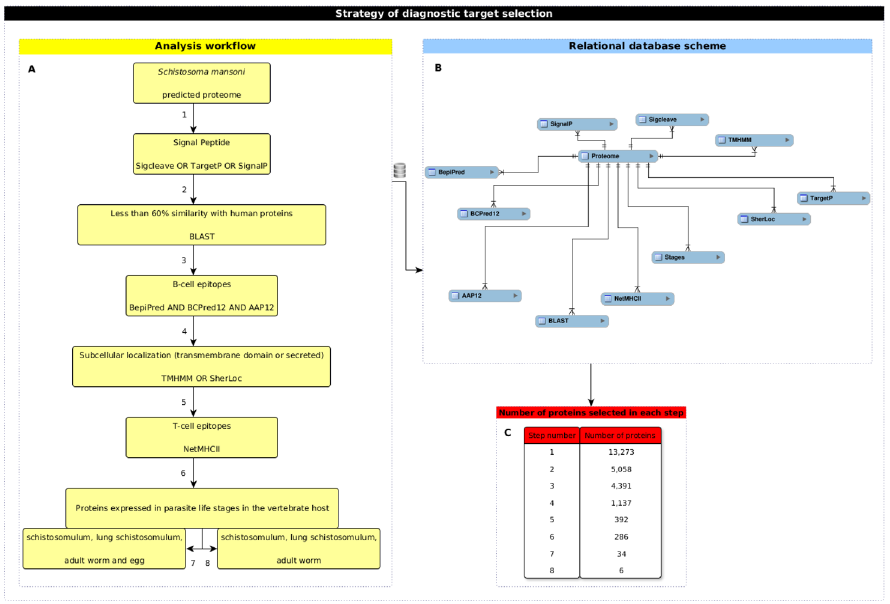
Fig 1. Strategy of diagnostic target selection. (A) Each step of the workflow analysiswas numbered accordingto the strategy used for target selection.(B) Schematicrepresentation of the relationaldatabase developed to integrate data obtained after computational predictions. (C) Number of proteinsselectedafter each step from (A).